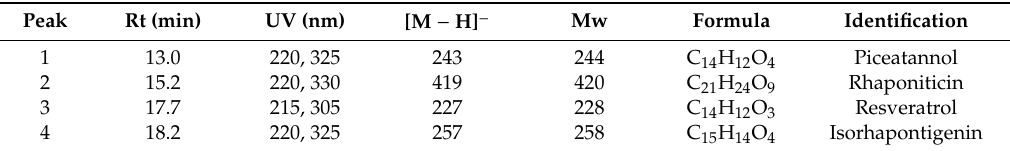
Figure 2. The chemical structures of four inhibitors from Gnetum parvifolium extract. Table 1. Identification of ligands in Gnetum parvifolium by liquid chromatography-mass spectrometry